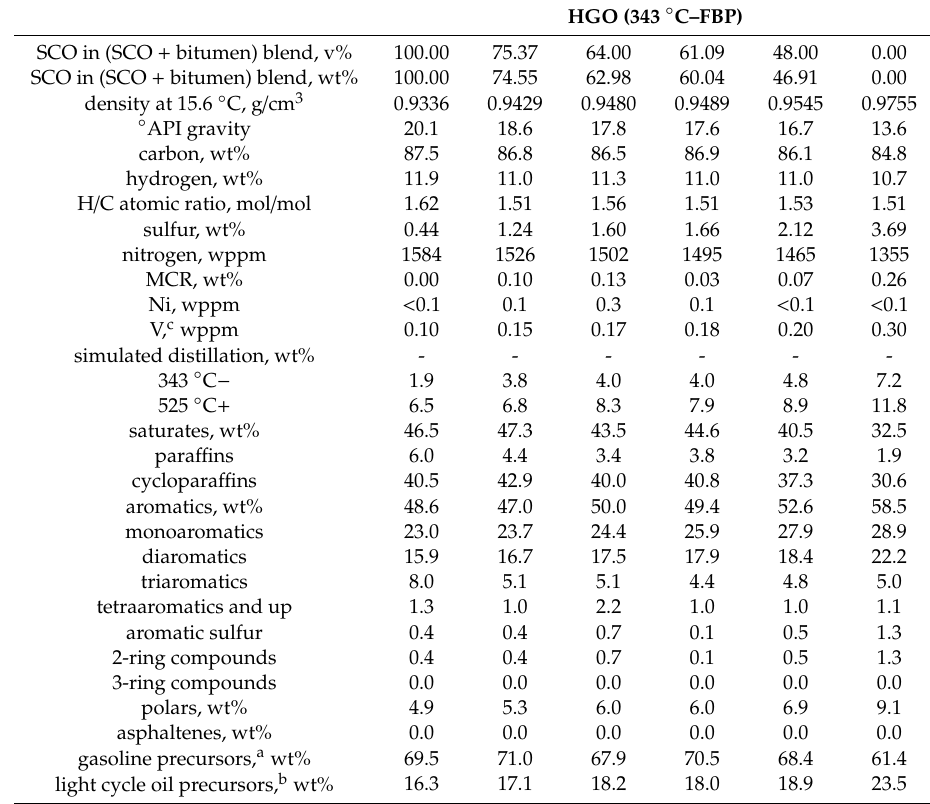
Table 1. Properties of the feedstocks used in this